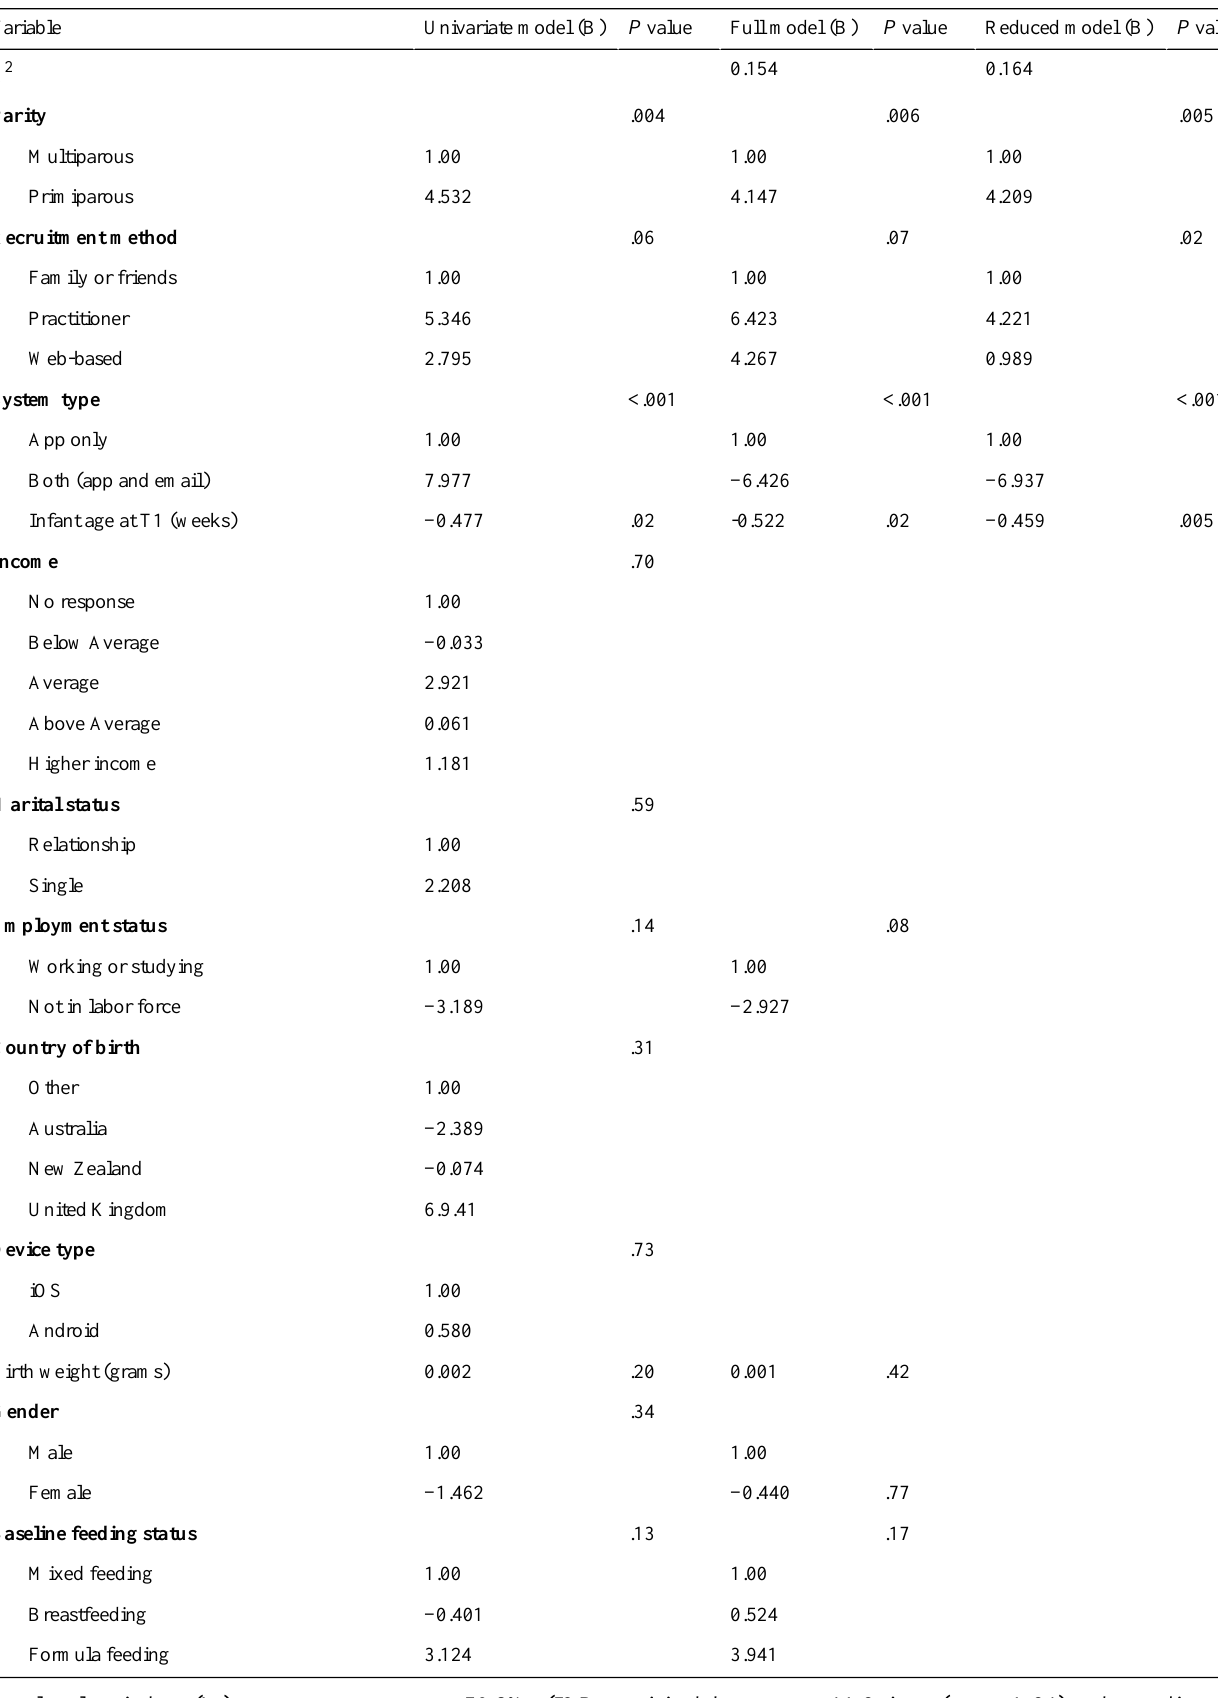
Table 2. Linear regression to explore the predictors of infant and participant characteristics with the engagement index